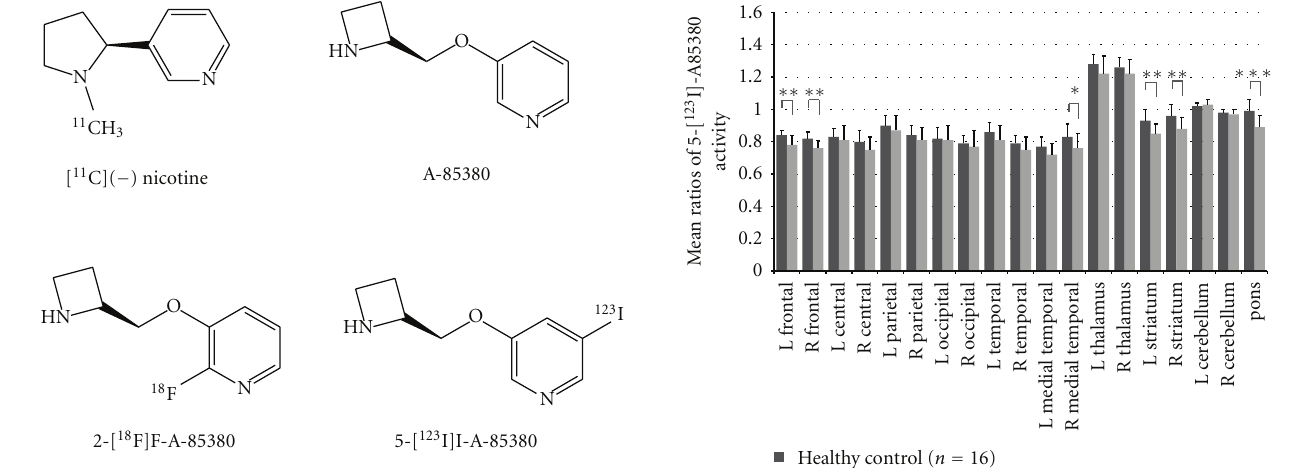
Figure 2: Chemical structures of radioligands for nAChRs.